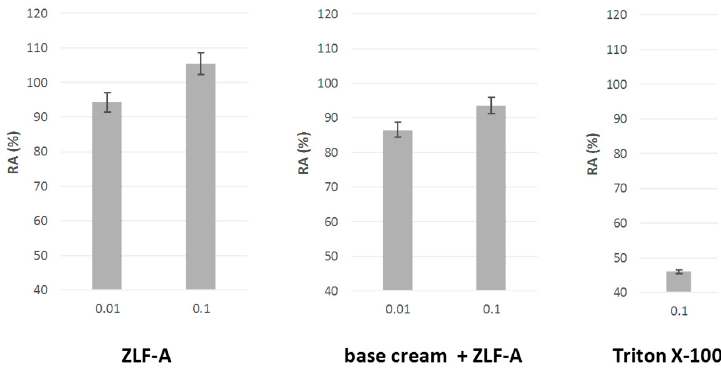
Figure 6. Mitochondrial redox activity (RA (%)) estimated by MTT test in Episkin ™ reconstructed